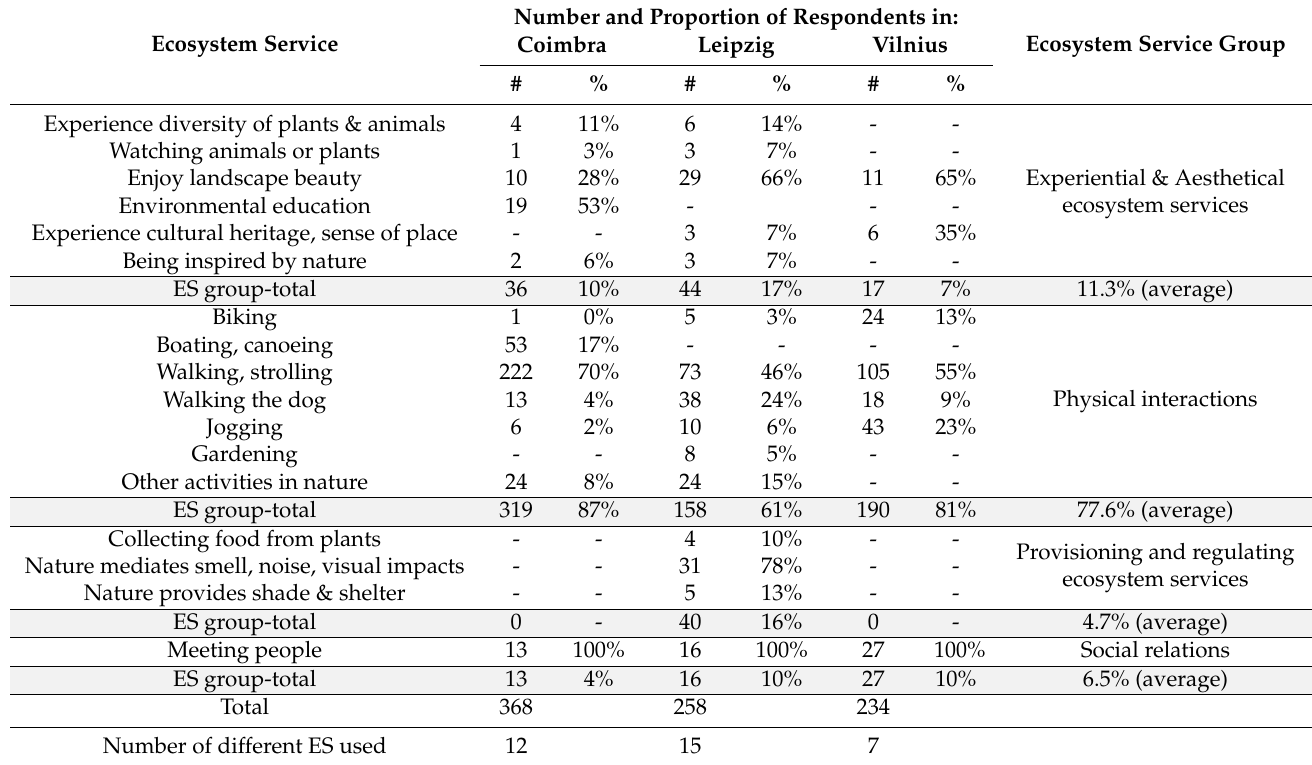
Table 2. Frequency and proportion of ES use in three European cities. ES percentages are calculated for each ES group separately; ES groups are calculated as percentages of total ES use per city and on average (in grey).